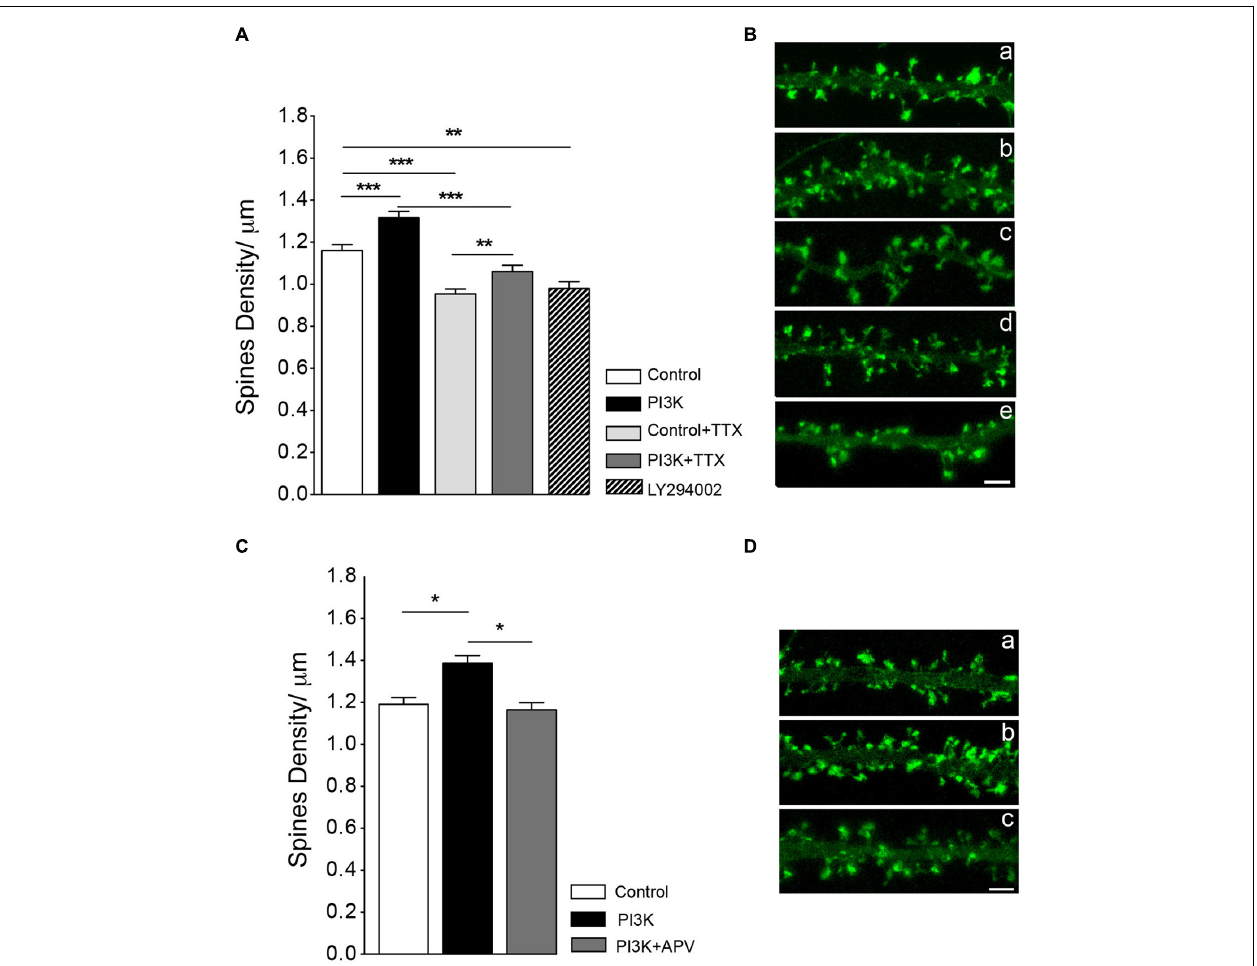
FIGURE 5 | Synaptic activity does not modulate spine formation in culture. (A) Neuronal activity is not required for PI3K-induced spine density increase. Spine density was quantified in cultures with and without PTD4-PI3KAc under normal conditions (control versus PI3K) and in cultures treated withTTX (2 μ M) for 48 h (control + TTX versus PI3K-TTX). Compared to the control cultures, PTD4-PI3KAc significantly increased spine density regardless neuronal activity (from 1.16 ± 0.03 to 1.32 ± 0.03 spines/ μ m withoutTTX and from 0.95 ± 0.02 to 1.06 ± 0.03 spines/ μ m withTTX). (Student’s t -test).Treatment with a PI3K inhibitor activity for 48 h, reduces spine density a 15% (0.9 ± 0.03 spines/ μ m). (B) Representative dendritic segments of actin-GFP transfected neurons after 21DIV in control (a), PTD4-PI3KAc-treated (b),TTX-treated (c),TTX + PTD4-PI3KAc-treated (d) and LY294002-treated cultures (e). Scale bar = 2.5 μ m.The number of dendrites